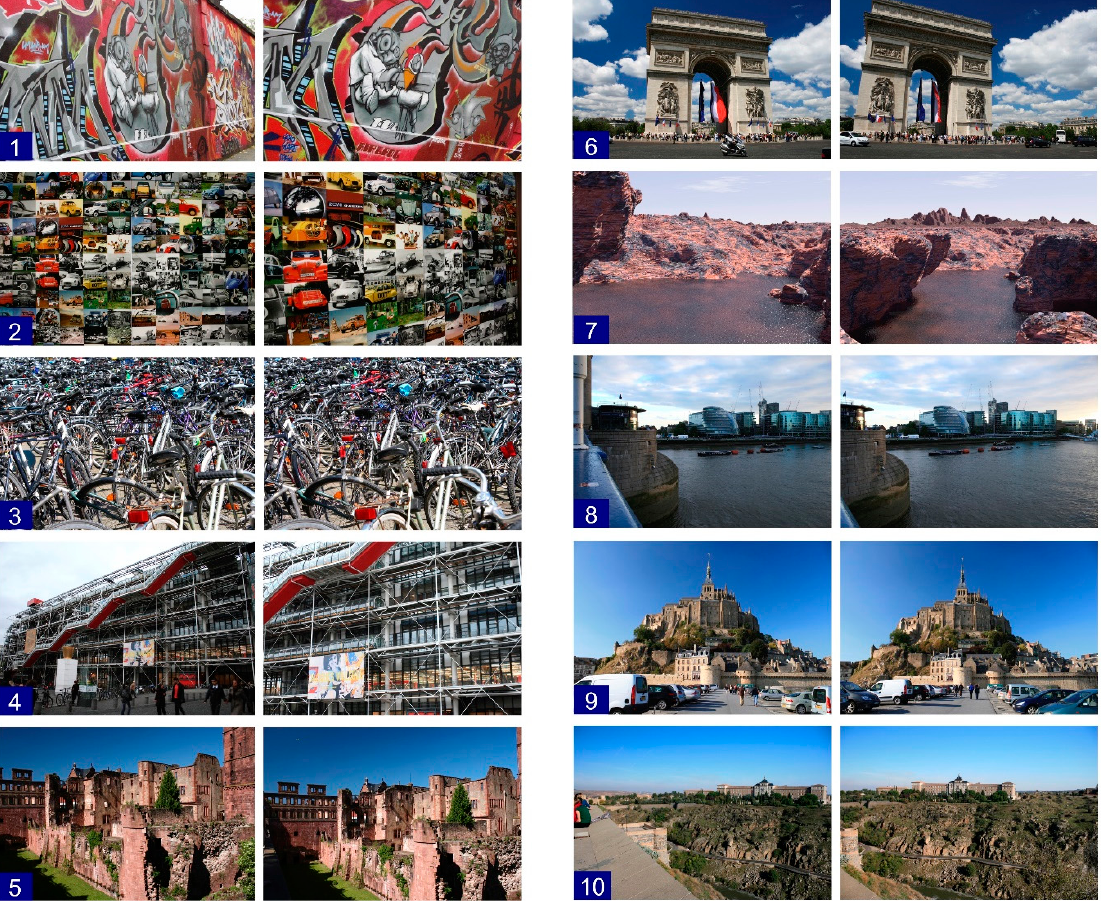
Figure 8. The outdoor image set.